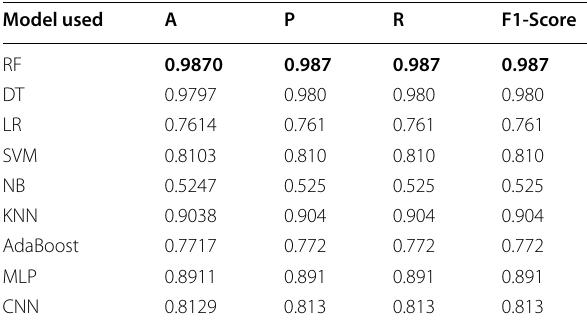
A-Accuracy, P-Precision, R-Recall, RF-Random Forest, DT-Decision Tree, LR-Logistic Regression, SVM-Support Vector Machine, NB-Naïve-Bayes, KNN-K The highest performance in terms of Accuracy, Precision, Recall, and F1-score are highlighted in bold Table 5 Results with Huffman encoding Model